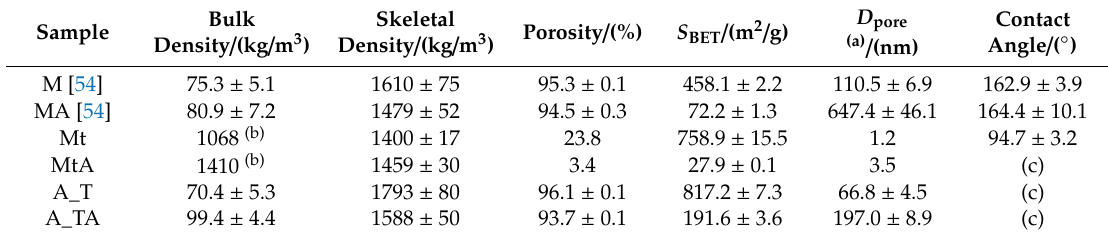
Table 2. Physical and structural properties of the